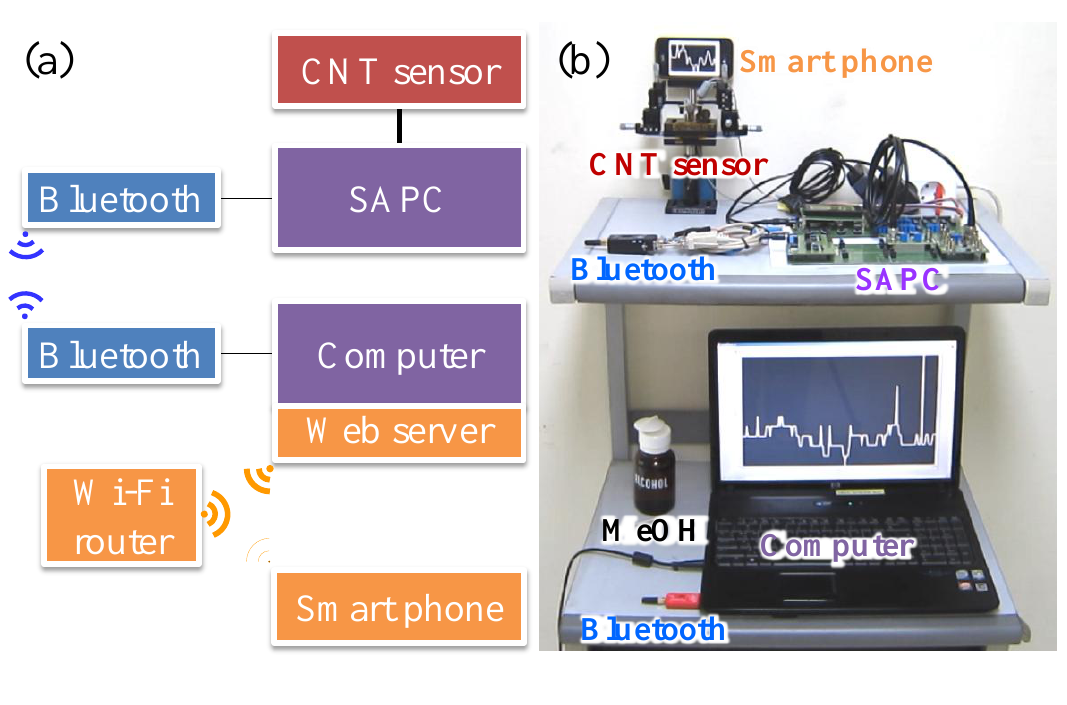
Figure 3. ( a ) Block diagram and ( b ) photograph of the wireless monitoring test